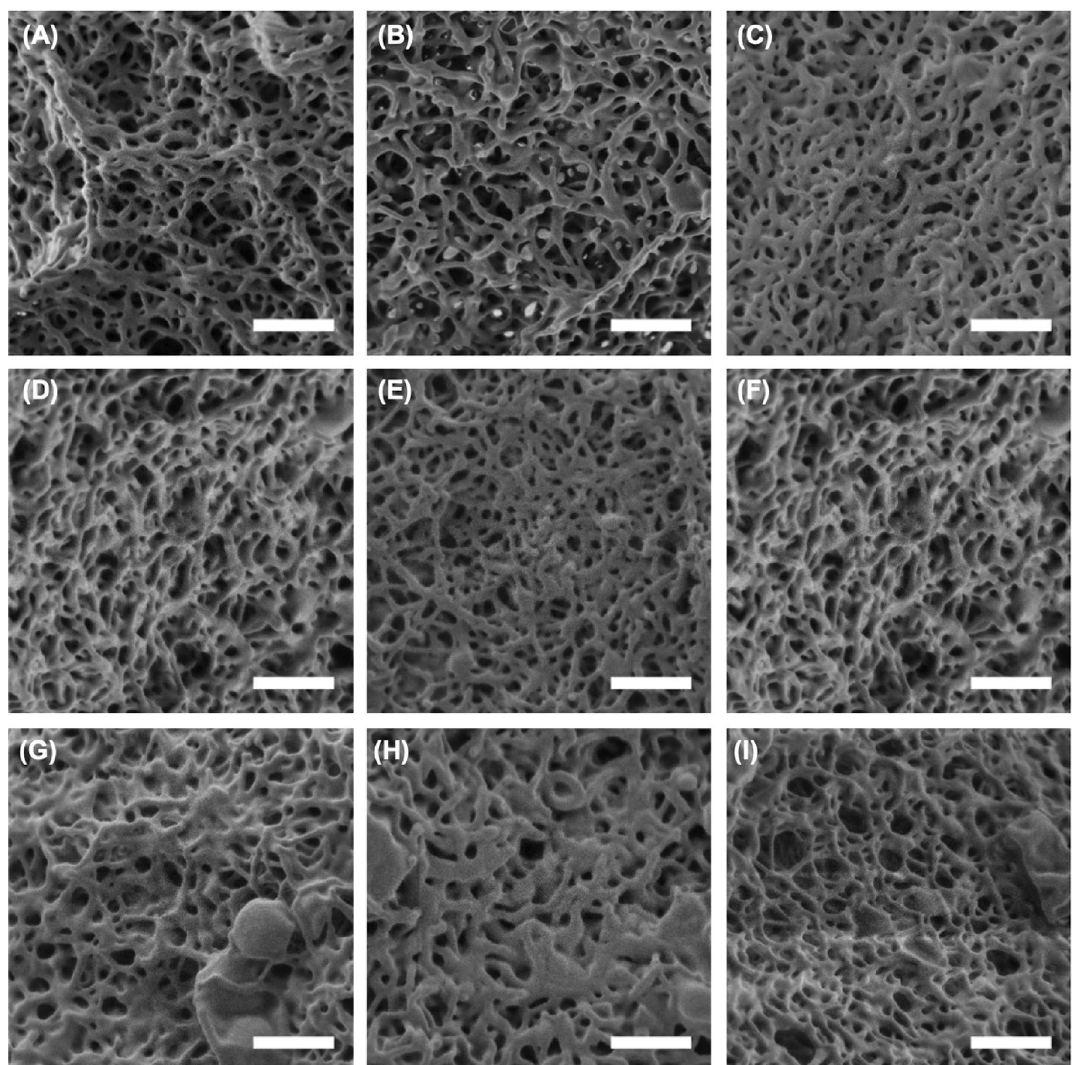
Figure 6. SEM images of the microstructure of the colloidal gels prepared with different colloidal building blocks. Gels prepared at room temperature by 10 wt% suspensions of uncrosslinked colloids with different aspect ratios: SWM NCC ( A ), MWM NCC ( B ) and LWM NCC ( C ), Gels prepared at room temperature by 10 wt% suspensions of highly crosslinked colloids with different aspect ratios: SWM HCC ( D ), MWM HCC ( E ) and LWM HCC ( F ) Gels prepared at 45 °C by 1.0 wt% suspensions of uncrosslinked colloids with different aspect ratios: and SWM NCC ( D ), MWM NCC ( E ) and LWM NCC ( F ). The scale bars are 500